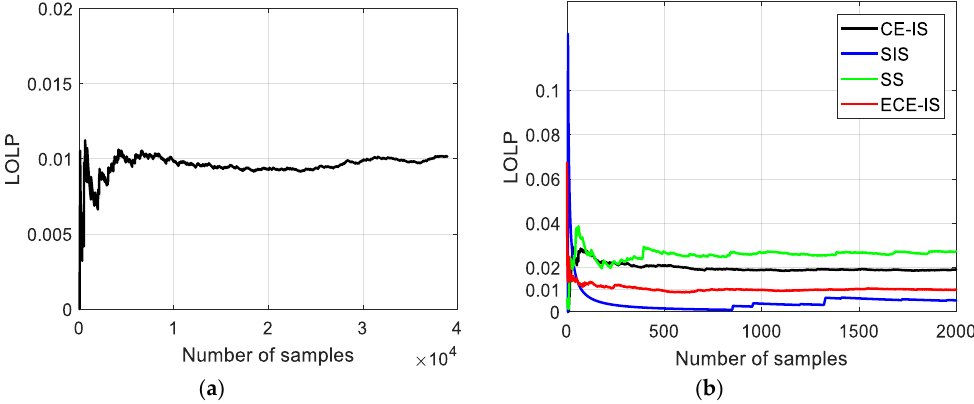
Figure 10. ( a ) System LOLP in case of using standard MCS method; ( b ) system LOLP in case of using CE-IS, SIS, SS, and ECE-IS approaches.